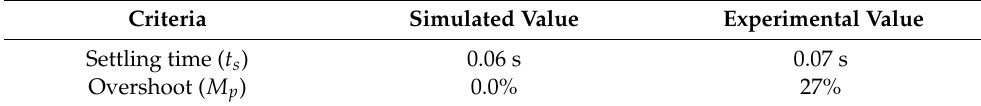
Table 6. Direct axis current controller